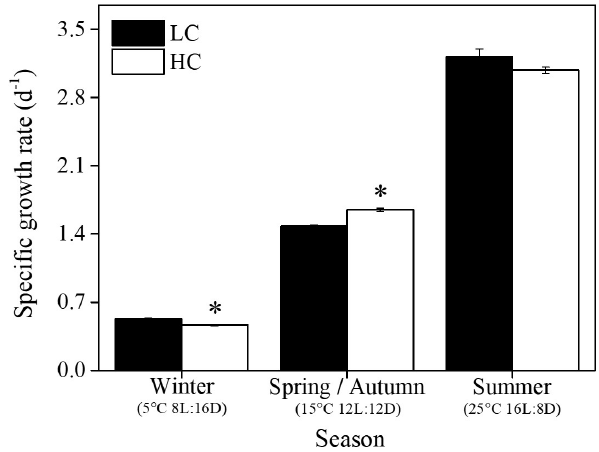
Figure 1. Specific growth rate of S. costatum acclimated to ambient (LC, black bars) and elevated p CO 2 (HC, white bars) under dif- ferent combination of temperature and photoperiod conditions. The data are mean ± SD values of triplicate cultures ( n = 3). Asterisks represent significant differences ( P < 0 . 05) between two CO 2 lev- els under the same season conditions ( t